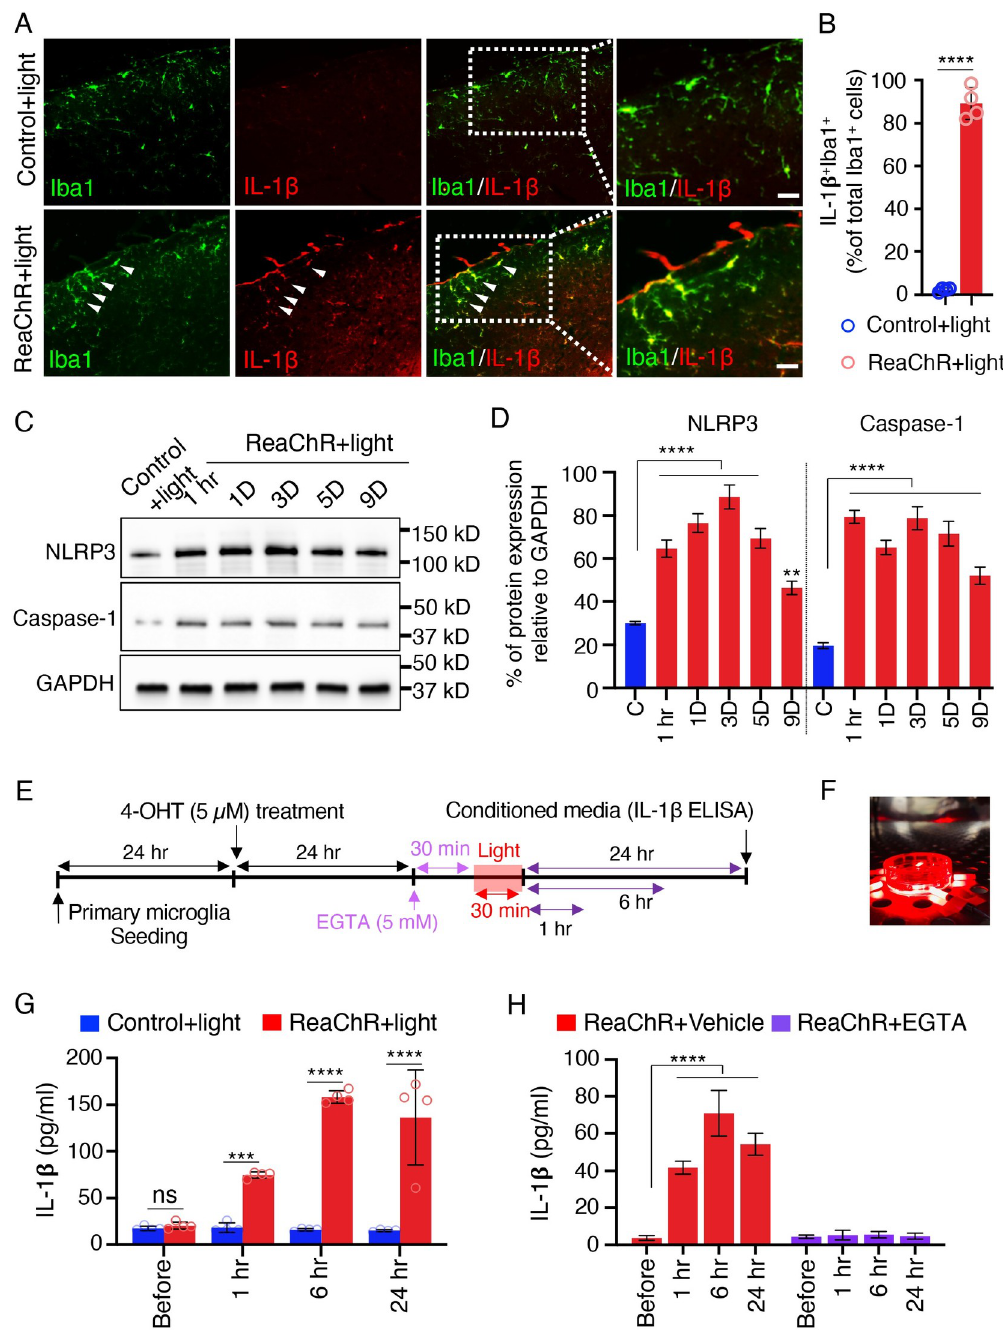
Fig 6. Optogenetic stimulation of microglia increases IL-1 β production and release. (A) Representative immunostaining images showing IL-1 β (red) up-regulation in Iba1 + (green) cells in the spinal cord of ReaChR mice at 1 day after light stimulation but not in the control group. Scale bar, 40 μ m. (B) Summarized data showing the co-localization of IL-1 β with Iba1 + cells. n = 4 mice/group, ���� P < 0.0001. Unpaired Student t test. (C, D) Representative western blot images and quantification data showing NLRP3, Caspase-1, and IL-1 β expression in the L4-5 level of the dorsal horn after optogenetic stimulation. Data are presented as mean ± SEM. n = 4–6 mice/group, GAPDH was used as internal control. ���� P < 0.0001. One-way ANOVA with multi-comparisons. Uncropped western blot images were included in the Supporting information file. (E) Timeline of experimental procedures for ReaChR induction, optogenetic stimulation, and IL-1 β ELISA from cultured microglia. (F) Image showing light stimulation of primary ReaChR microglia in culture. (G) Pooled ELISA results indicating the released IL-1 β in culture media of primary microglia following optogenetic stimulation. Light stimulation increases IL-1